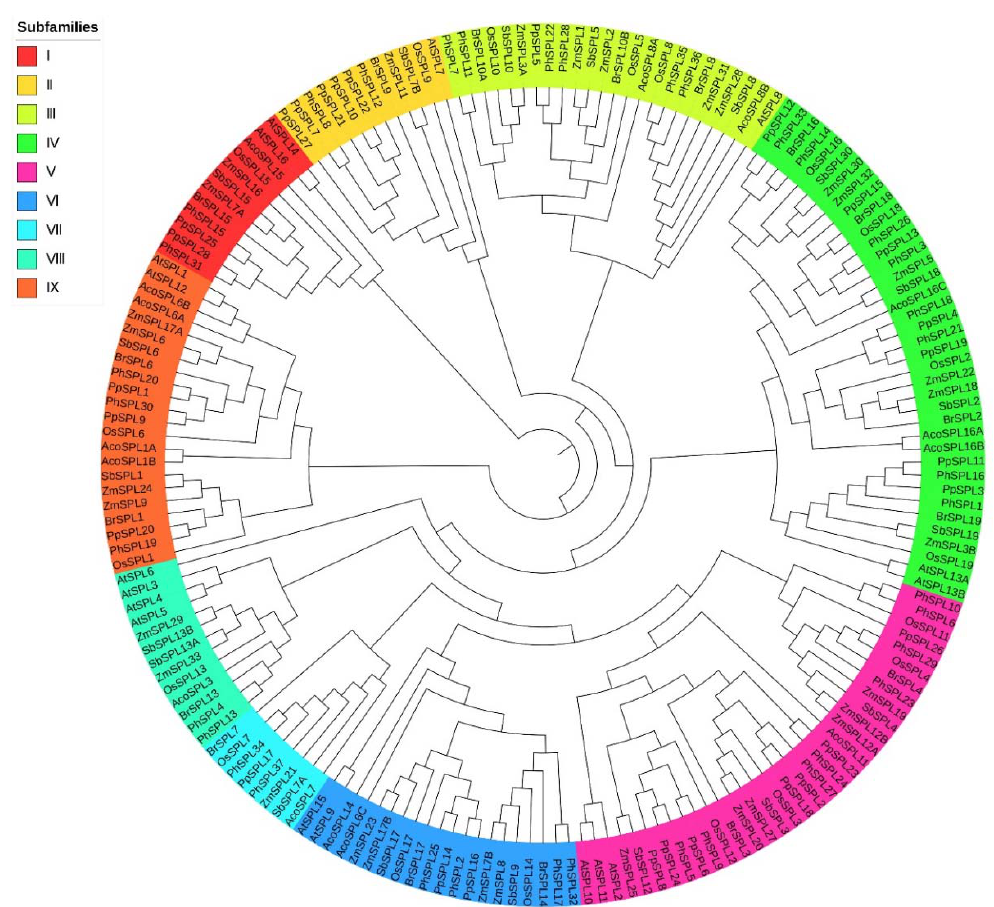
Figure 2. Phylogenetic tree of 28 PpSPLs and 155 SPLs from 7 other plant species. The phylogenetic tree of the 183 SPL genes was constructed using the ML (maximum likelihood) method by RAxML. The tree can be divided into nine groups and each color represents a group. AtSPLs , the SPLs from Arabidopsis thaliana ; AcoSLPs , the SPLs from Ananas comosus ; BrSPLs , the SPLs from Brachypodium distachyon ; OsSLPs , the SPLs from Oryza sativa ; PhSLPs , the SPLs from Phyllostachys edulis ; PpSLPs , the SPLs from Pleioblastus pygmaeus ; SbSLPs , the SPLs from Sorghum bicolor ; ZmSLPs , the SPLs from Zea mays .